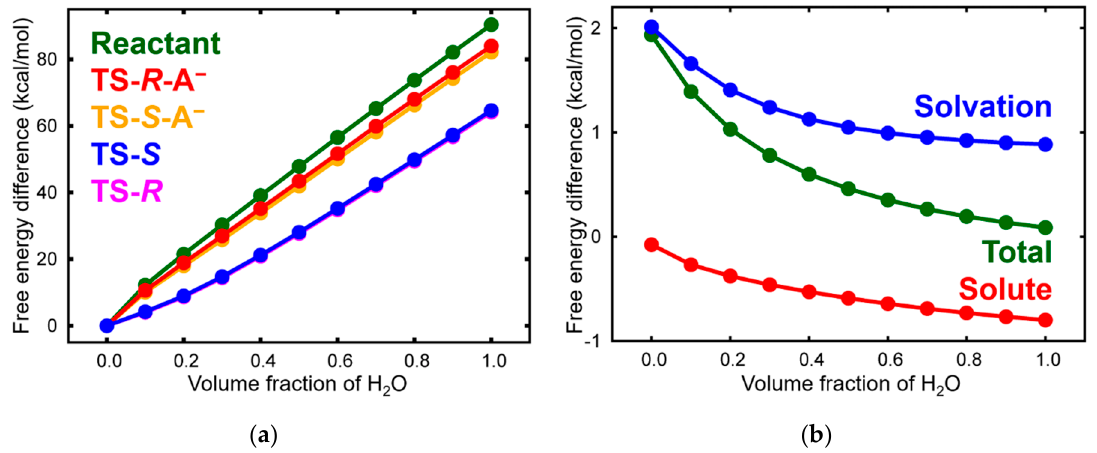
Figure 4. ( a ) Calculated free energy changes of reactant and TSs. The free energies at x(H 2 O) = 0 (pure DMF solution) are set to be zero. The free energy di ff erences of reactant, TS- R -A − , TS- S -A − , TS- R , and TS- S are shown in green, red, orange, purple, and blue lines, respectively. ( b ) Di ff erences of activation free energy, solute internal energy and solvation free energy between TS- R -A − and TS- S -A − . Di ff erences of activation free energy, solute internal energy and solvation free energy are shown in green, red, and blue lines, respectively.